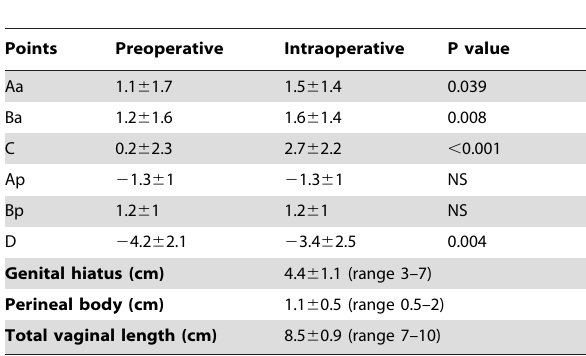
Table 2. POPQ measurements with the Valsalva